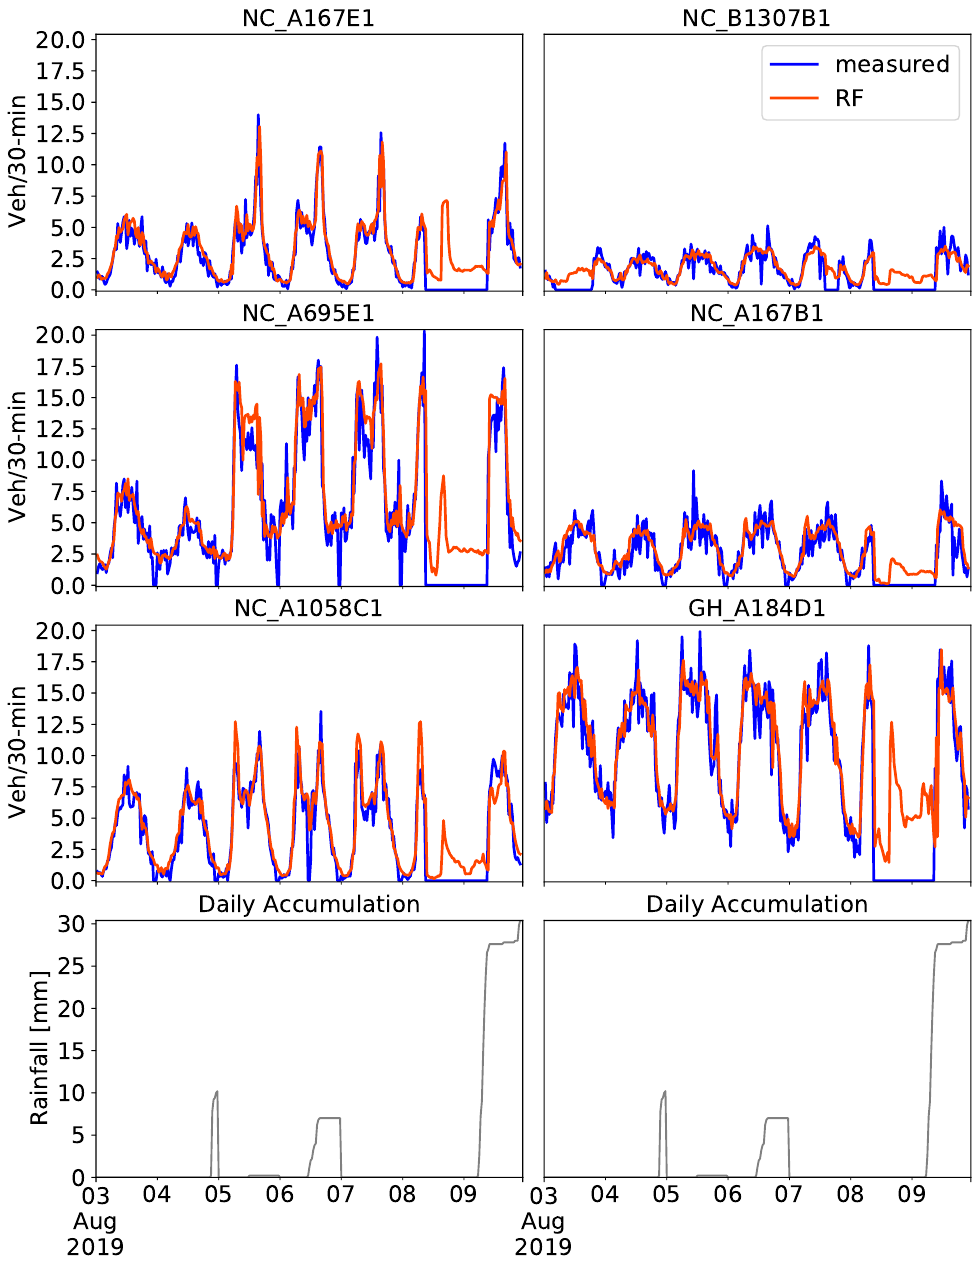
Figure 11. Predictions on 3–9 August 2019 obtained with the RF tuned model using the past four months of training data including nine exogenous attributes, four of which refer to four nearby cameras. Measured traffic volume constitutes the “ground truth”. Daily accumulated rainfall is illustrated in